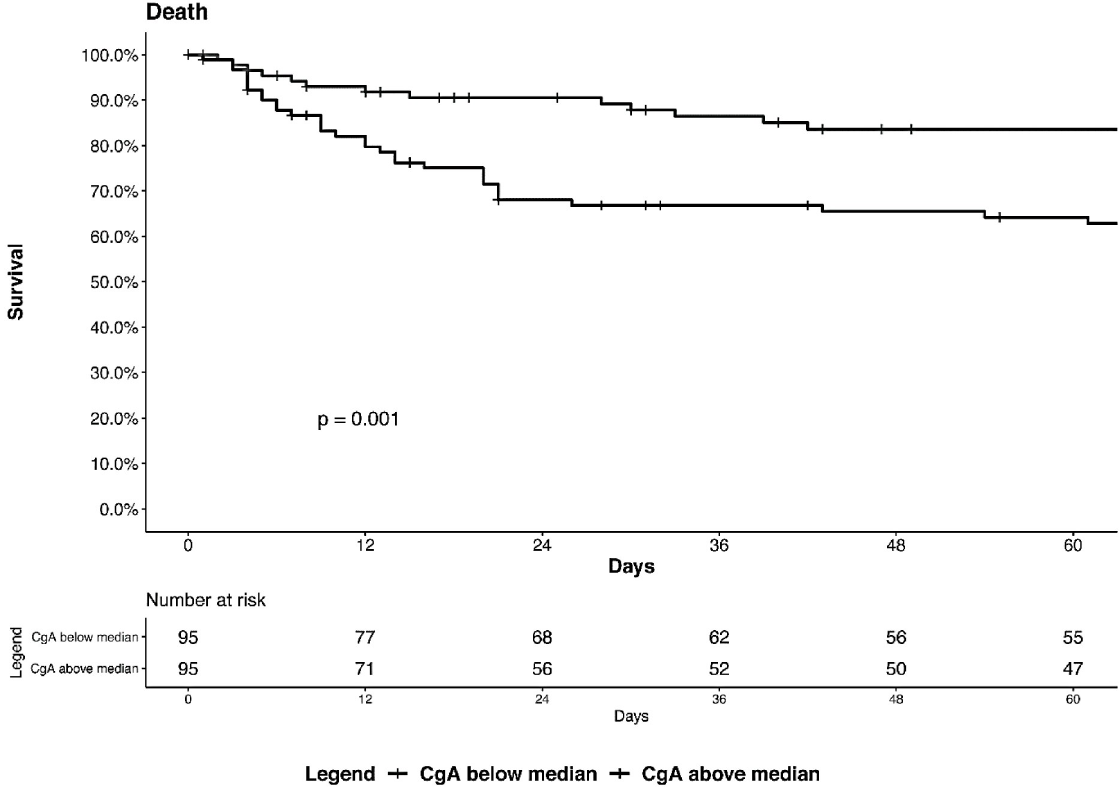
Fig 3. Kaplan-Meier survival curves in patients with CgA levels below (low) or above (high) the median value of 0.558 nM. Log rank test, p = 0.001.